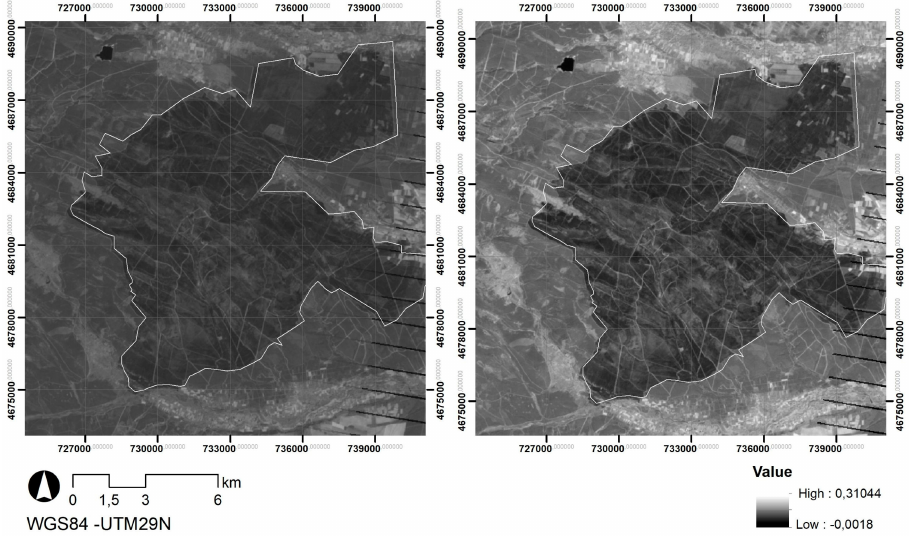
Figure 3. The immediately-after-fire LSA short ( left ) and immediately-after-fire LSA NIR ( right